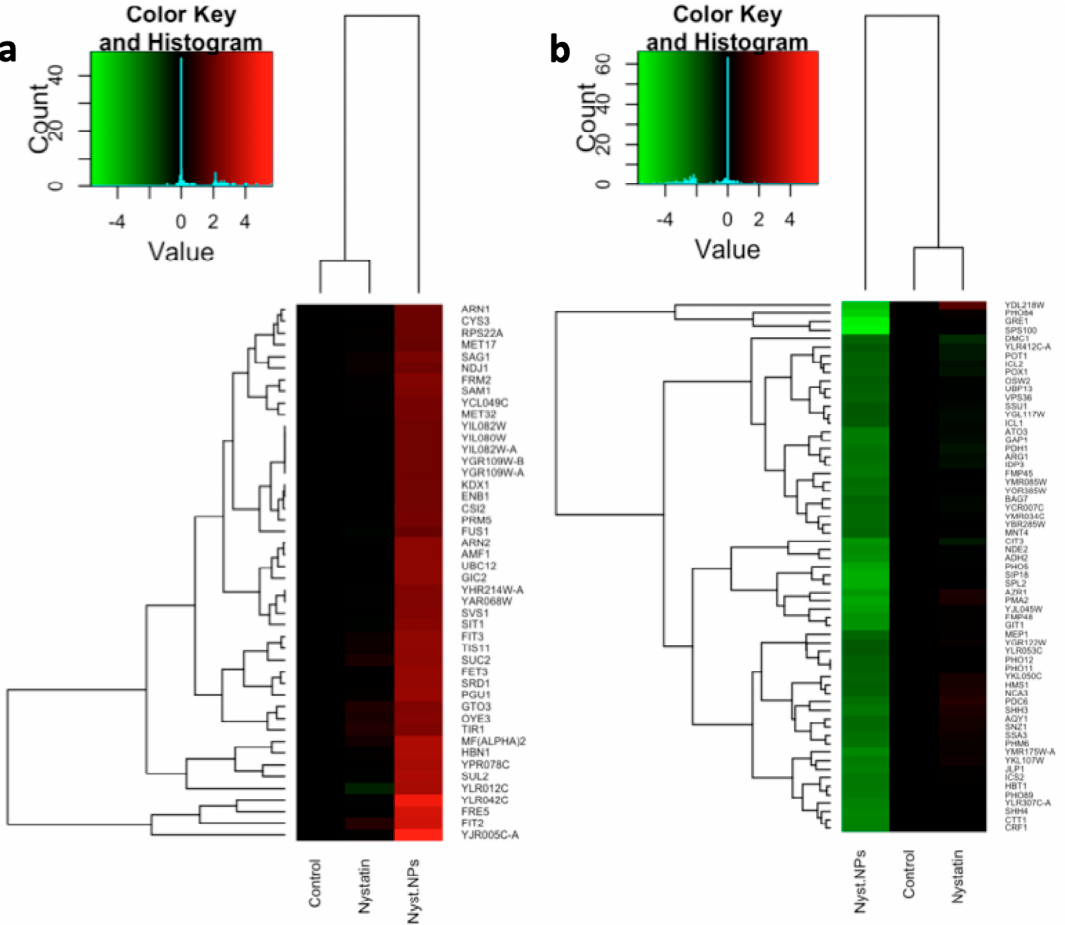
Figure 1. Heatmaps of the ( a ) up-regulated and ( b ) down-regulated genes highlighted from the microarray data analyses (fixed thresholds of +2; − 2). Control untreated, Nystatin (0.25 mg·L − 1 ) and Nystatin (0.25 mg·L − 1 ) supplemented with CdS QDs (100 mg·L − 1 ).